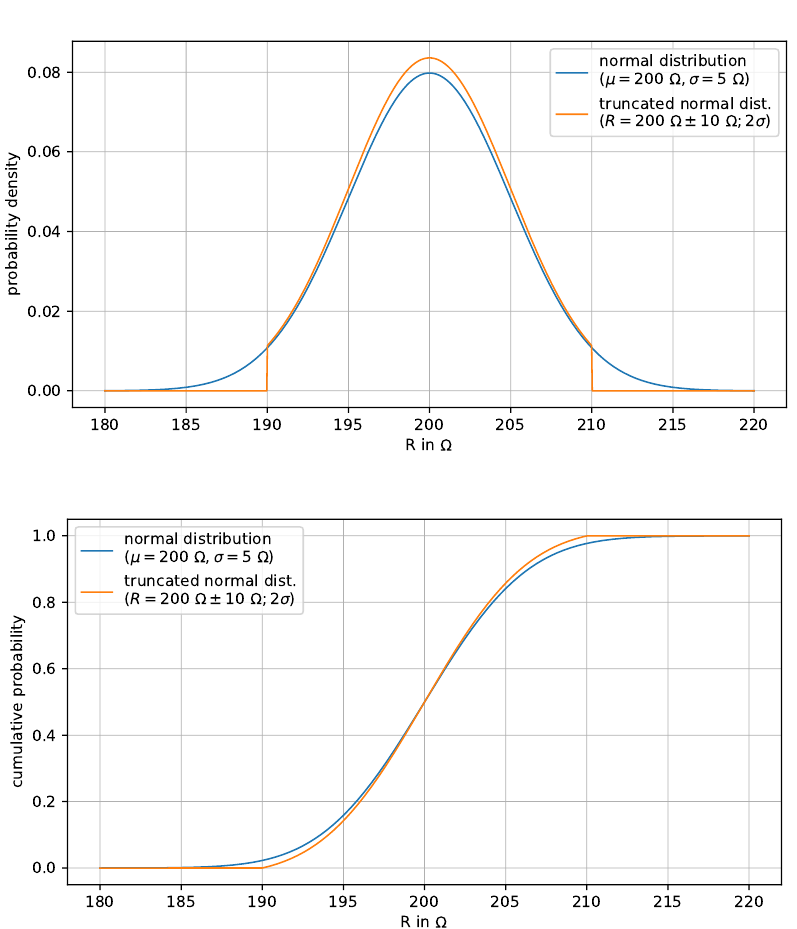
Figure 3. Probability density and cumulative probability of the truncated normal distribution (orange curve) of resistance R = 200 Ω ± 10 Ω , 2 σ such that the underlying (nontruncated) normal distribution (blue curve) has mean value µ = 200 Ω and standard deviation σ = 5 Ω (= 10 Ω /2 ) . The probability is 100% for the truncated normal distribution that a value of R is between 190 Ω and 210 Ω and the probability is 95.4% for the underlying normal distribution for this